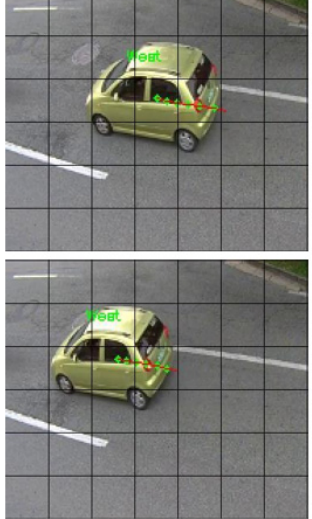
Figure 6. Displacement of a car within N = 6 frames.